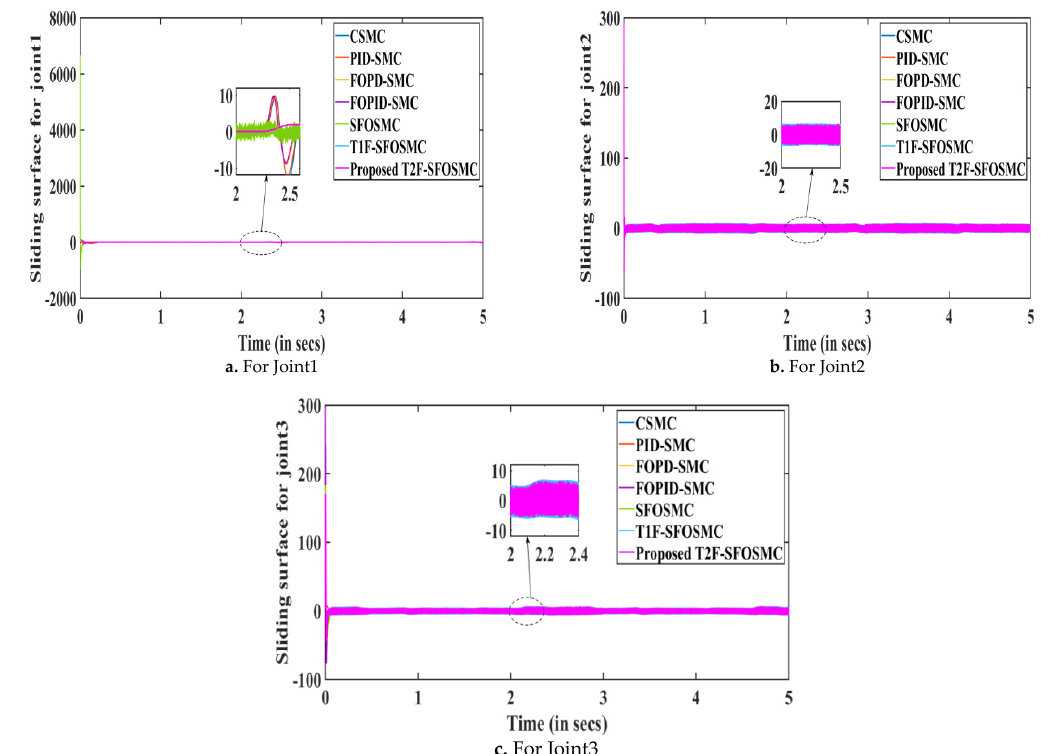
Figure 11. Sliding surfaces for Joint1, Joint2 and Joint3 of the 3DOF surgical manipulator. The time response parameters of various controllers for the 3DOF surgical manipu- lator’s joint1 have been displayed in Table 2. It is observed that the proposed T2F-SFOSMC has greater precision, minimum overshoot and undershoot, minimum in- tegral square error (ISE) and better tracking compared to other controllers for nonlinear multi-incision trajectory, which are the primary requirements of a surgical robot. The achieved accuracy is less than 1mm, which is within the permissible limit. Similarly, the parameters can be found for other joints also. The gain parameters of discussed control- lers are displayed in Table 3, which are found using PSO. Table 2. Time response parameters of various controllers for the 3DOF surgical manipulator’s Joint1 for 1st and 2nd cycle. Specifications Controllers